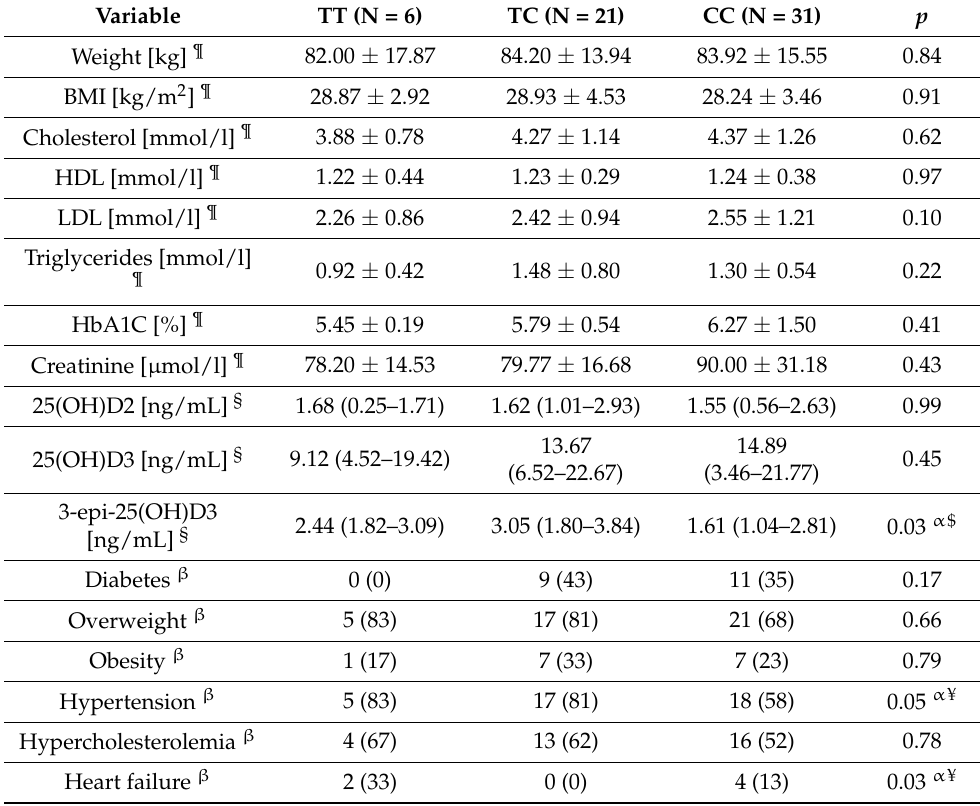
Table 6. Patient characteristics according to the FokI polymorphism.